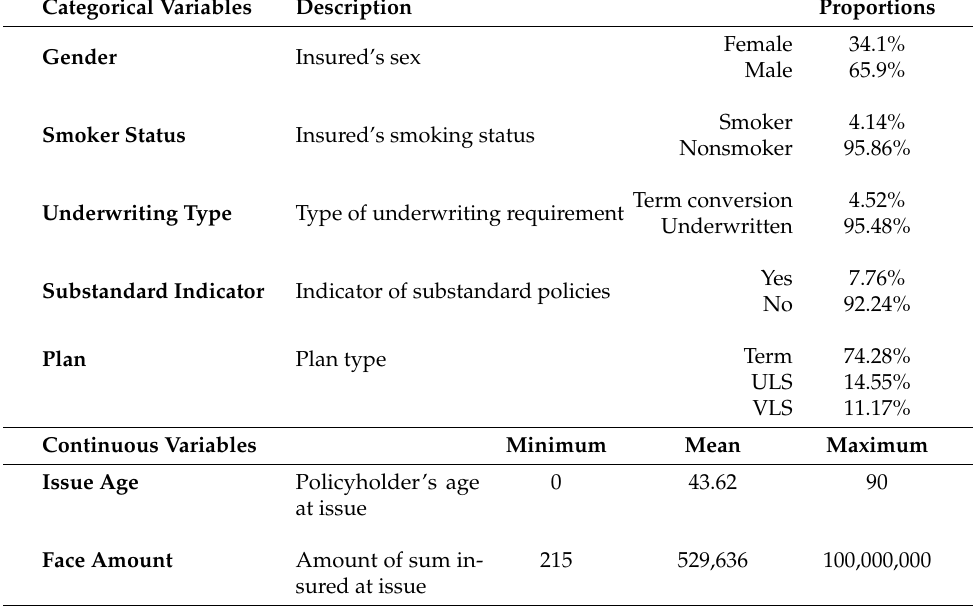
Table 1. Descriptions of variables in the mortality